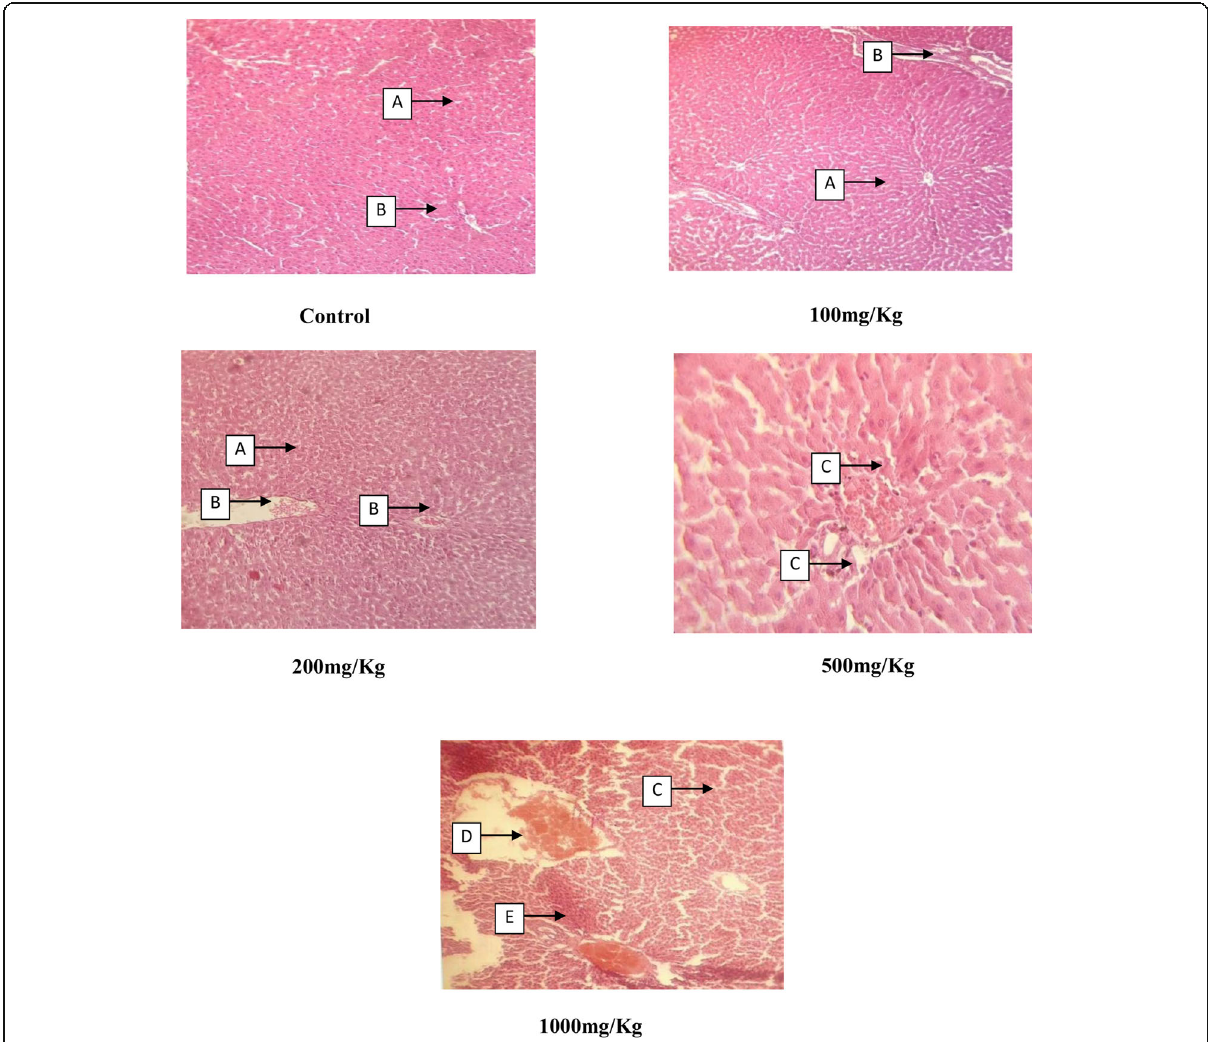
Fig. 7 Effect of Dennetia tripetalla methanol extract on Liver Architecture (H&E ×